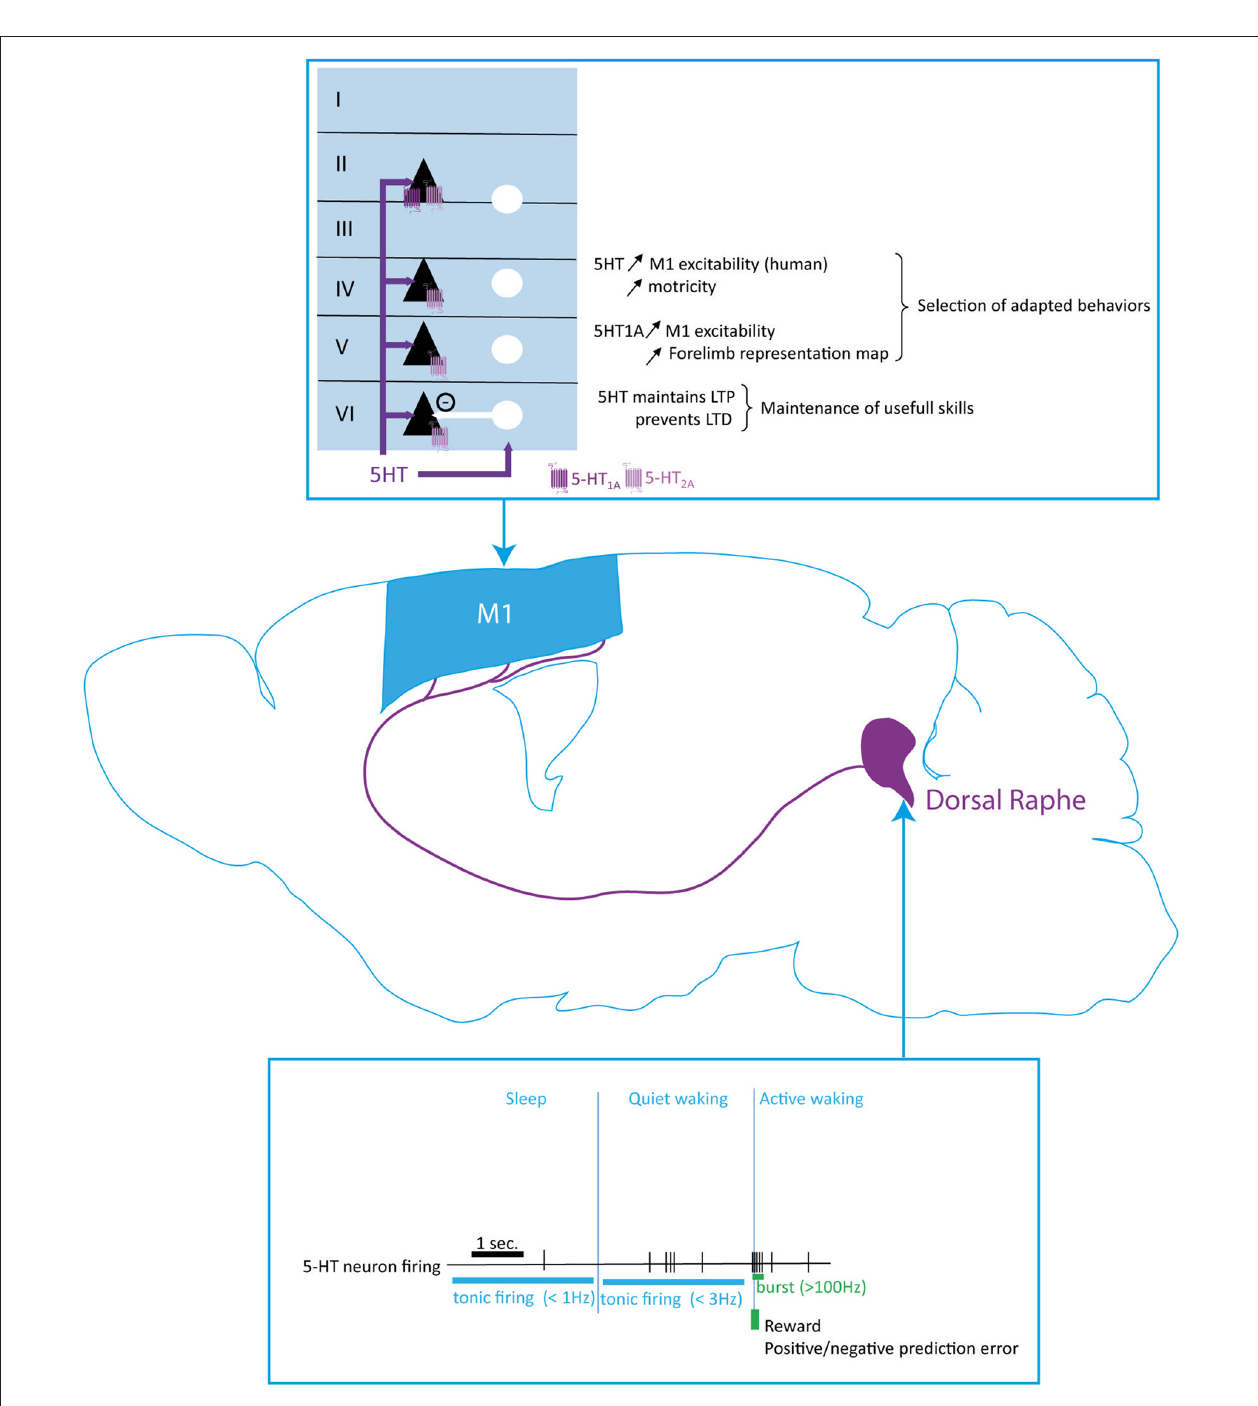
FIGURE 4 | Serotoninergic modulation of the motor cortex function. Serotoninergic neurons from the dorsal raphe (DR) nucleus innervate all cortical layers in M1. The 5-HT neurons different firing frequency and patterns, which are determined by the sleep-wake cycle and response to external stimuli, modifies the extracellular 5-HT level to enhance motor cortex excitability and regulate the maintenance of long term potentiation (LTP). Serotonin plays a key role in the selection of adapted behaviors and maintenance of useful skills. 5-HT, serotonin; PN, pyramidal neuron; IN, interneuron.